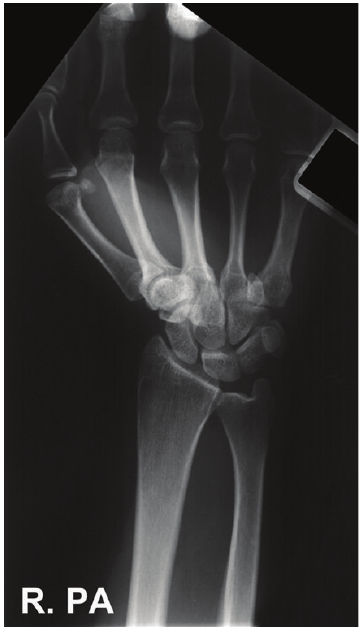
Figure 1: On arrival AP radiograph of the injured right wrist demonstrating the abnormal appearance of the ulnar styloid: it is lying adjacent to the ulnar notch of the radius.